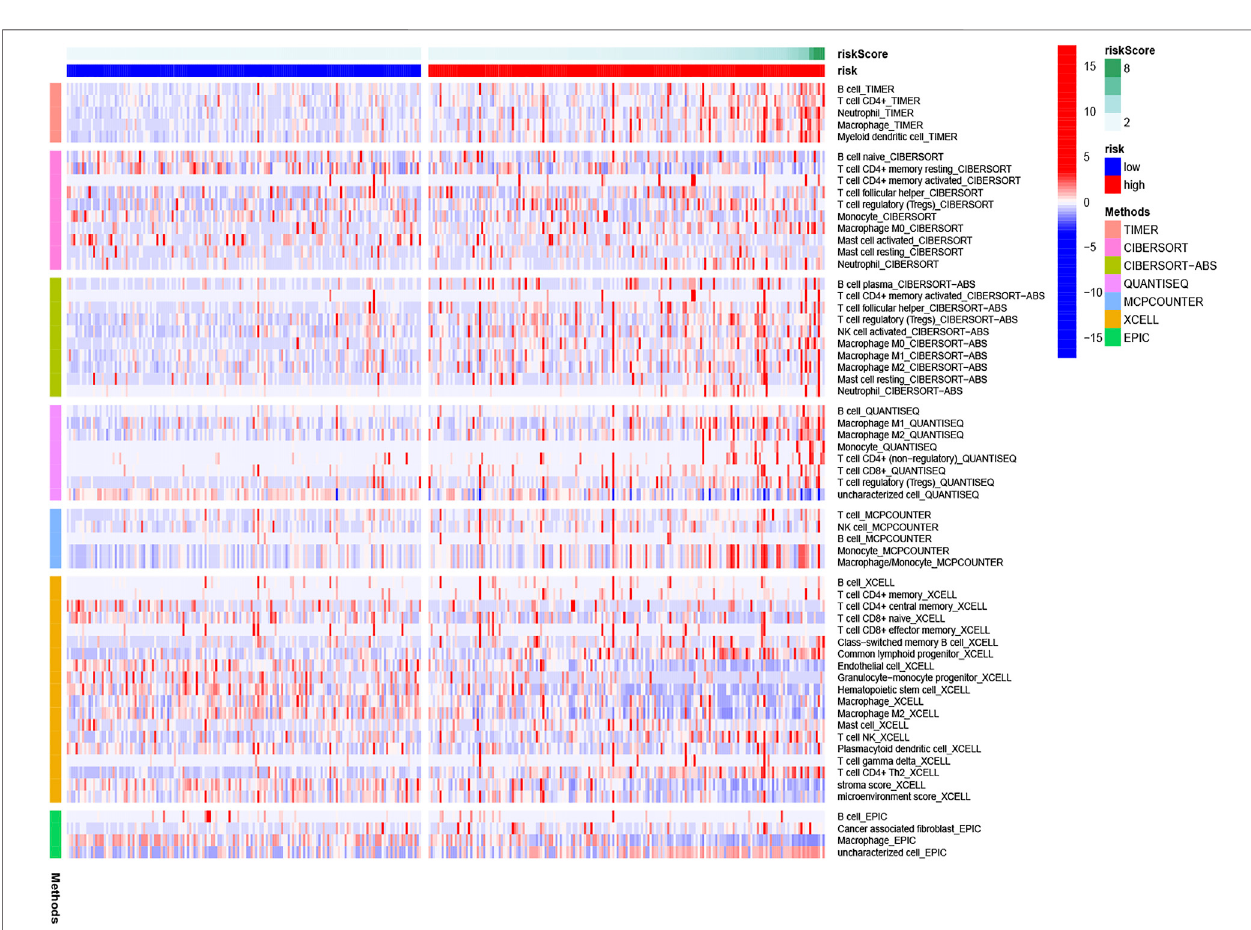
FIGURE8| HeatmapforimmunecellsbasedonEPIC,CIBERSORT − ABS,CIBERSORT,QUANTISEQ,XCELL,MCPcounter,andTIMERalgorithmsbetweentwo risk groups.